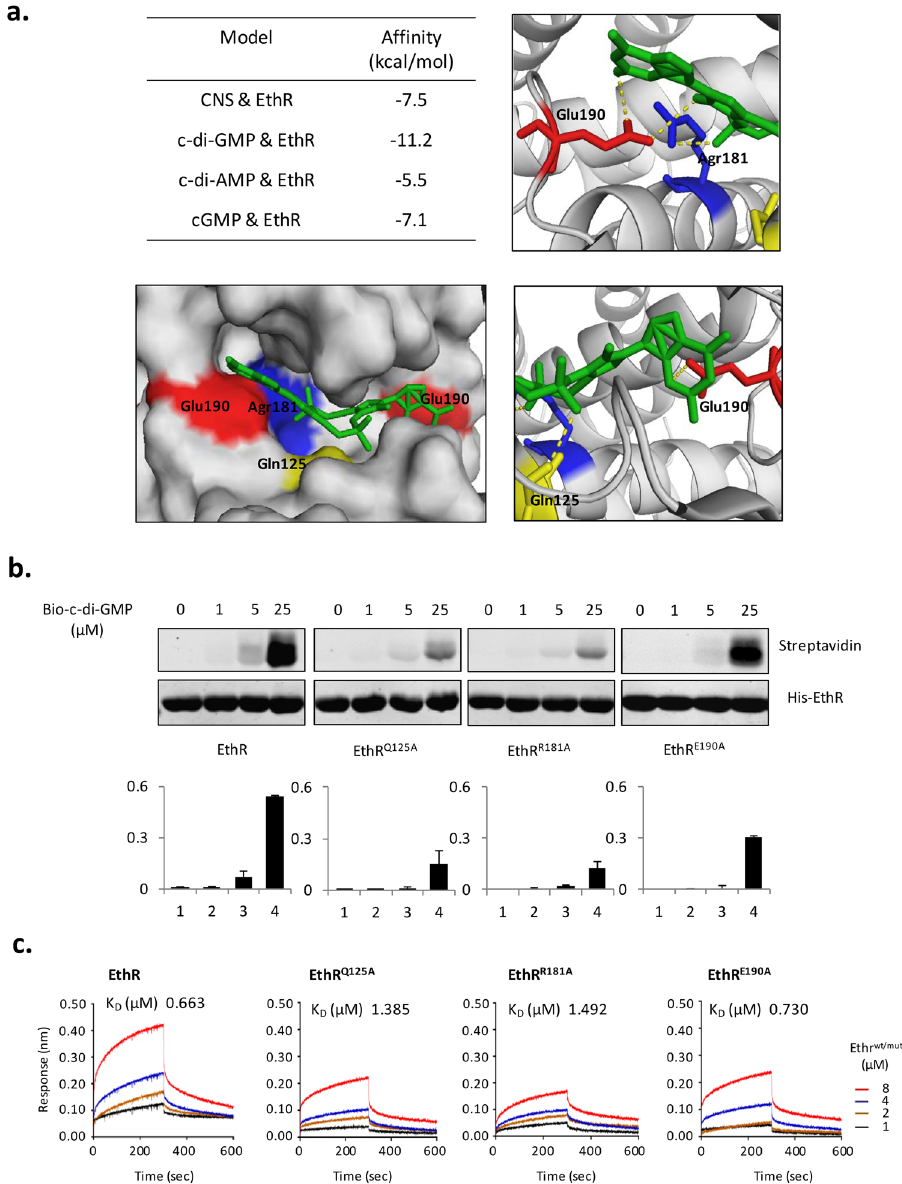
Figure 4. c-di-GMP binds to Ethr at Q125, R181, E190. ( a ). Docking model analysis for the binding of c-di- GMP to Ethr. Ethr was docked to c-di-GMP, c-di-AMP, cGMP, and CNS (as a positive control). The docking data is shown in the table (left). In the Ethr-c-di-GMP docking model, c-di-GMP (middle) is mediated at Watson-Crick (WC) edge of guanine bases by glutamic acid E190, and at phosphate group by arginine R181 and glutamine Q125. The PDB code of Ethr crystal structure used for the Ethr-c-di-GMP docking model is 1U9O. ( b ). UV cross-linking assay for validating the binding of Ethr mutants to c-di-GMP. Ethr and mutants of Ethr Q125A , Ethr R181A , Ethr E190A , were co-incubated with various concentration of biotinylation c-di-GMP. ( c ). BLI assay for validating the binding of Ethr mutants to c-di-GMP. Bio-c-di-GMP immobilized on streptavidin coated biosensor and co-incubated with various concentrations of Ethr or